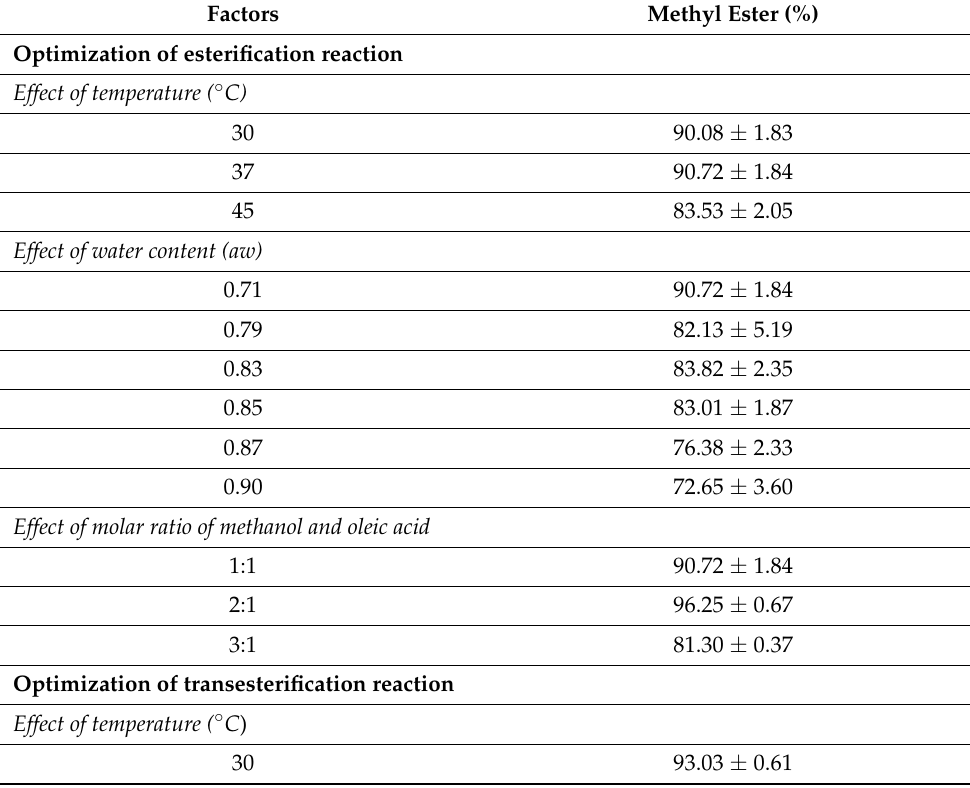
Table 2. Optimization of the esterification and transesterification for synthesis of